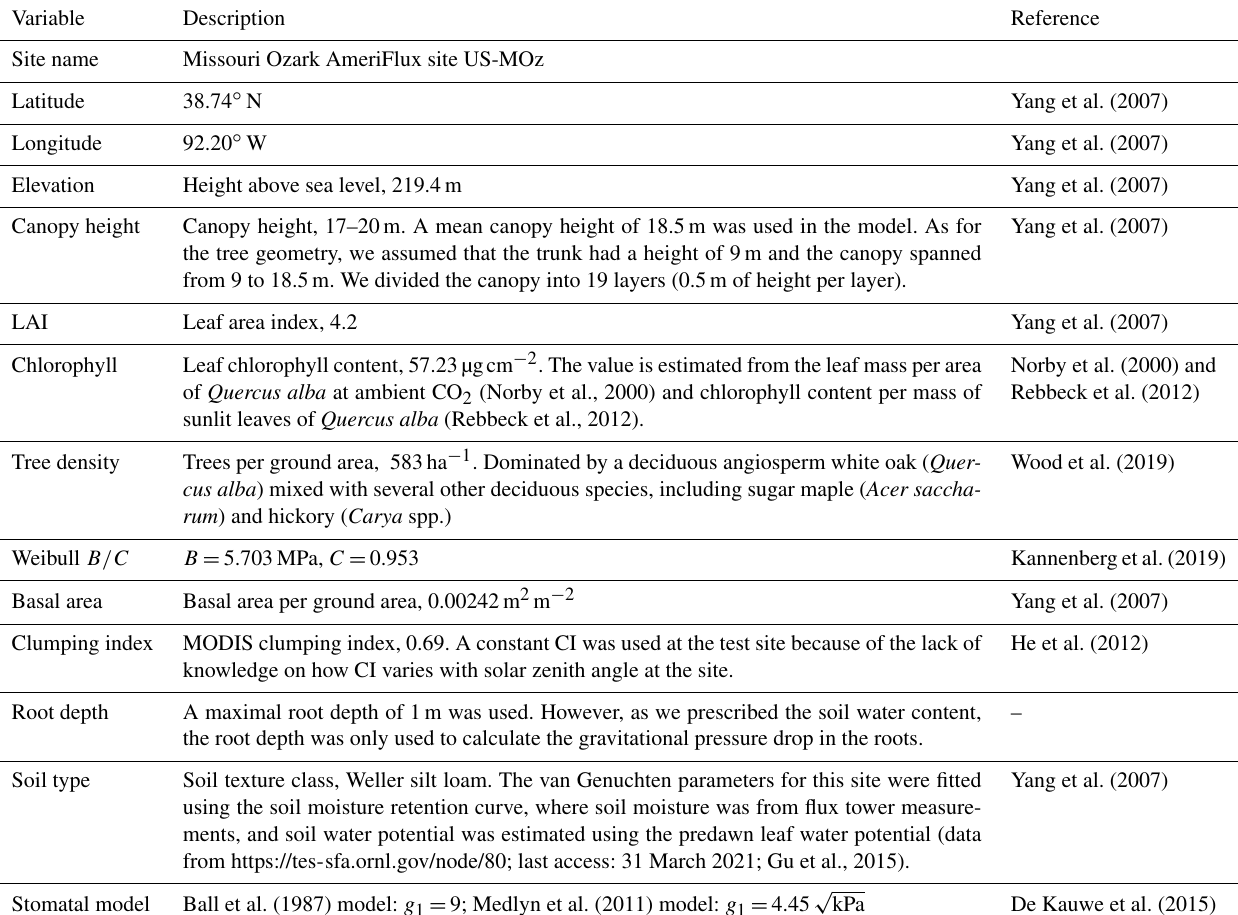
Table 2. Site and plant information of the Missouri Ozark flux tower site (MOFLUX). See Table 1 for how each parameter is used in the